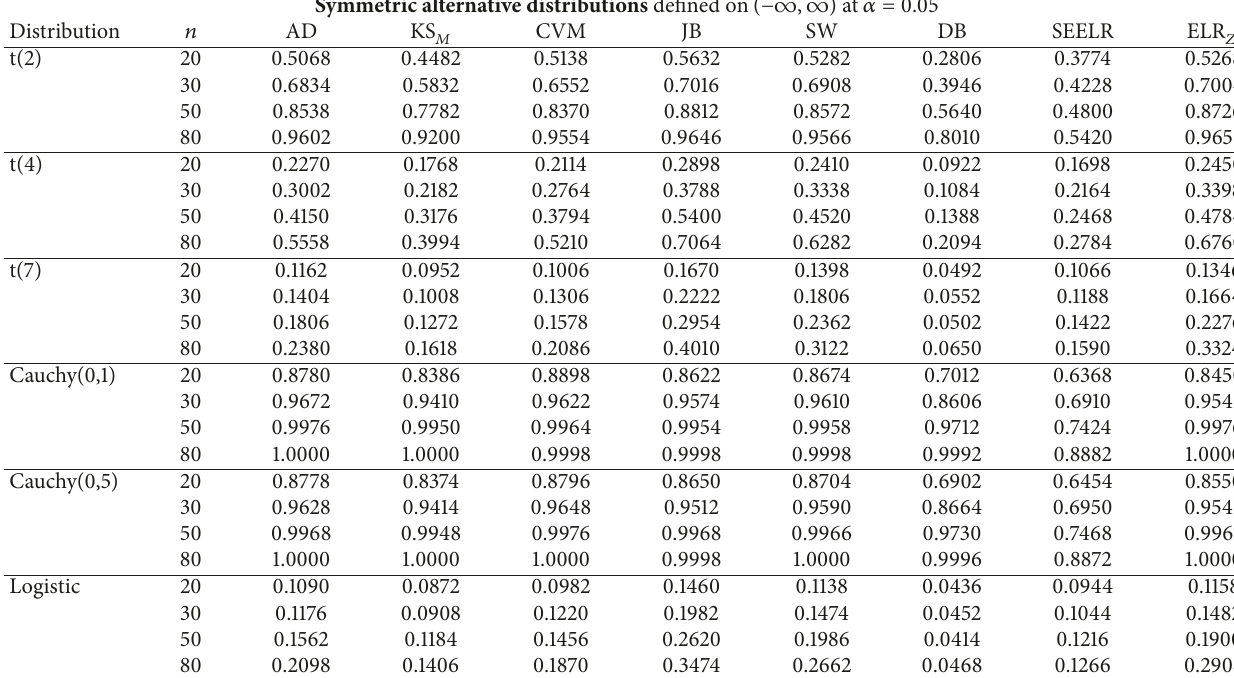
Table 5: Results of the Monte Carlo power comparisons based on samples with sizes (𝑛) from symmetric alternative distributions defined on (−∞, ∞) at 𝛼 = 0.05 .